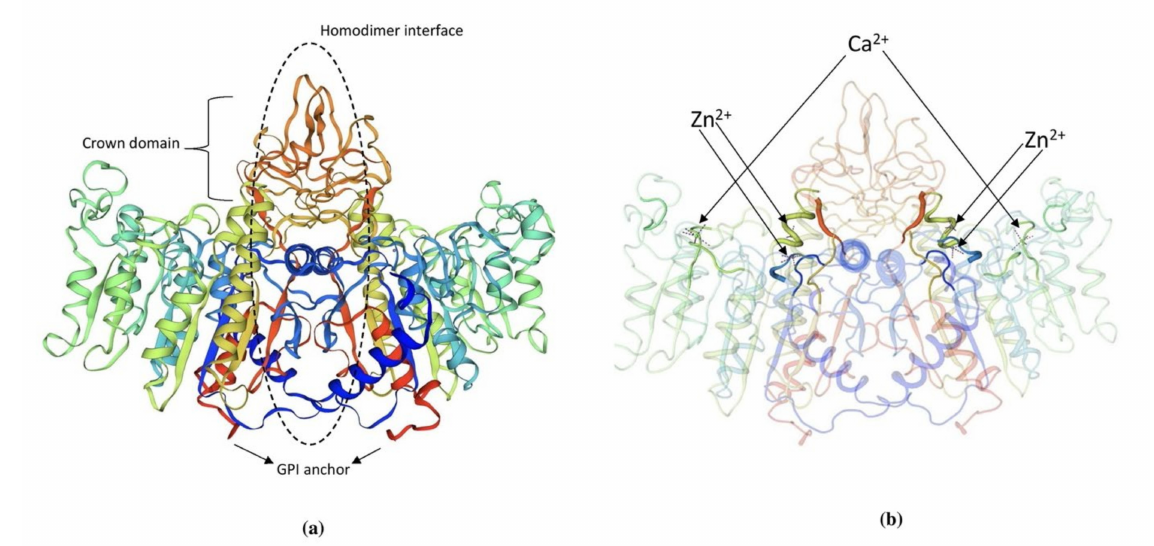
Figure 2. ( a ) 3D structure of human PLAP indicating crown domain, GPI anchor and the homodimer interface regions. ( b ) The presence of zinc and calcium ions is clearly indicated in the PLAP structure. The structure was exported from https://swissmodel.expasy.org/, accessed on 1 August 2021. (P05186